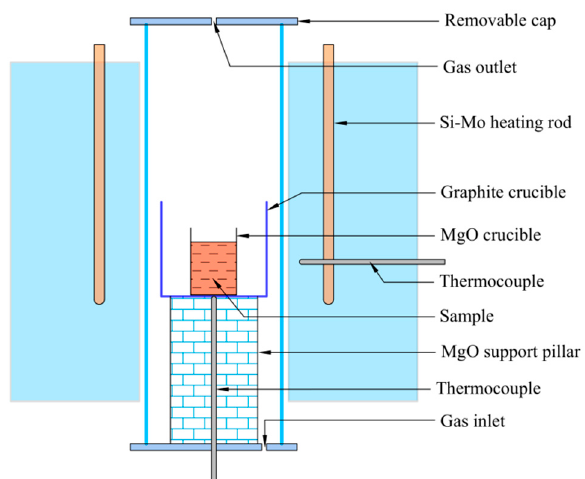
Figure 3. Schematic diagram of the tube furnace. Table 1. Chemical compositions of melting alloys.